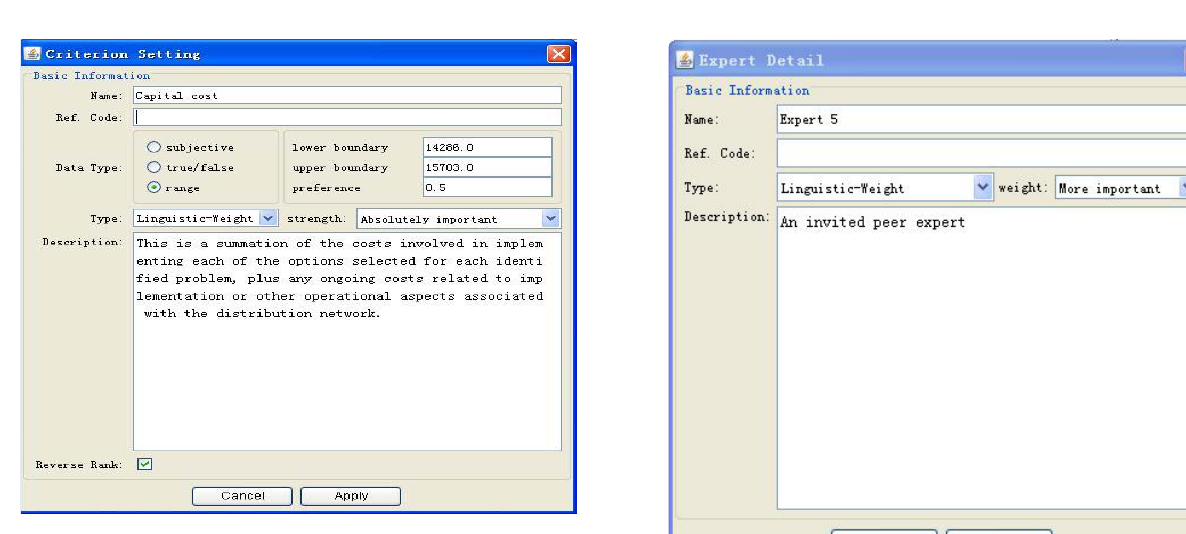
Fig.7. Data entry process of a criterion